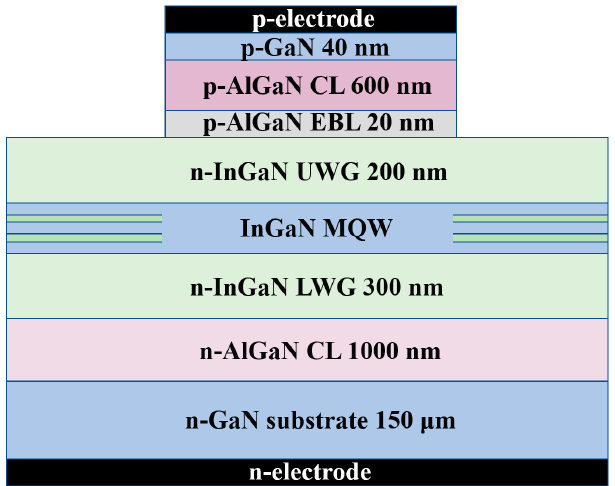
Figure 1. Schematic diagram of InGaN-based green LD structure for simulation by LASTIP. Based on the conventional green LDs, two sets of different green LDs are designed in order to optimize carrier injection efficiency. In series I, seven LDs with varied indium content from 1% to 7% in quantum barrier layers are studied. In series II, a set of LDs with a new composite LWG structure is proposed and the effect is calculated. The composite LWG structure consists of an In 0.04 Ga 0.96 N inserting layer and an In 0.08 Ga 0.92 N layer. The total thickness of composite LWG layer is kept to 300 nm, while the thickness of In 0.04 Ga 0.96 N inserting layer varies from 50 nm, 20 nm, 5 nm, 3 nm, and 1 nm, respectively. The lasing wavelength of all these samples is still 520 nm under the condition of a fixed 23% In composition of the well layer, as shown by the results of